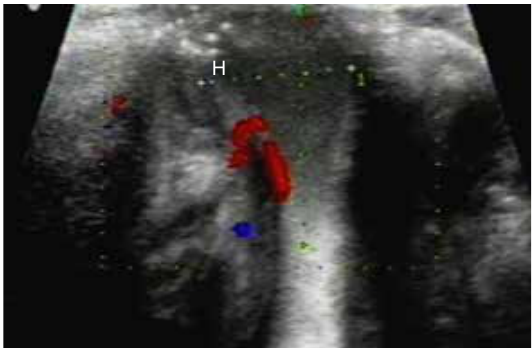
Figure 5 Hydrocolpocele was presented in a 15-day-old female neonate in this transperineal image. H, hydrocolpocele.